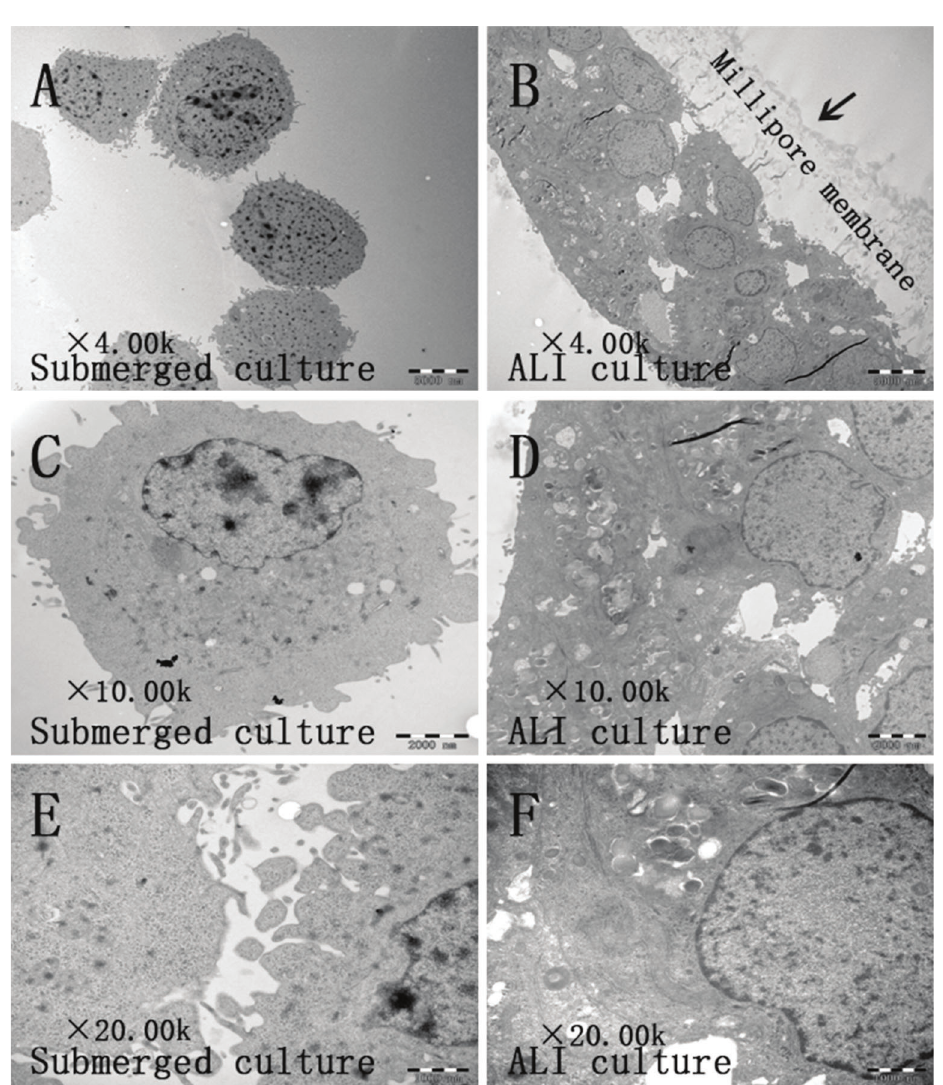
Figure 3. Transmission electron microscopy (TEM) of air-liquid interface (ALI) cultures and logarithmic phase of submerged cultures of A549 cells. A , C , and E , Different magni fi cations of submerged cultures showing a morphology of clear border and organelles and lack of obvious microvilli, although they had AECI-like outward appearance in some extent; B , D , and F , different magni fi cations of ALI cultured cells displaying a more compacted morphology with clear cell junction and abundant mucus on the apical surface. Magni fi cation bars: A and B=5000 nm; C and D=2000 nm; E and F=1000